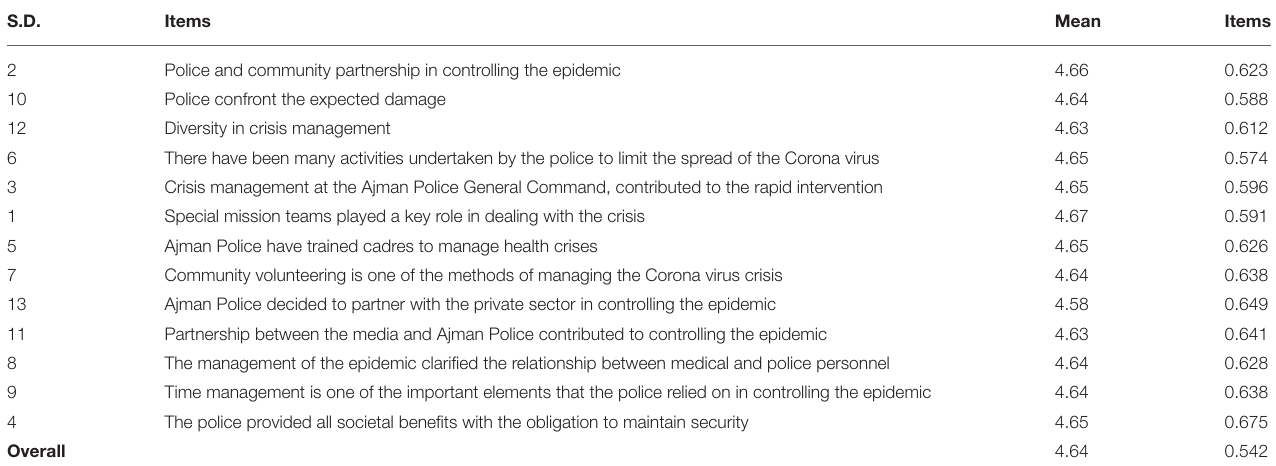
TABLE 1 | Ajman Police initiatives in dealing with the (Covid-19) crisis.